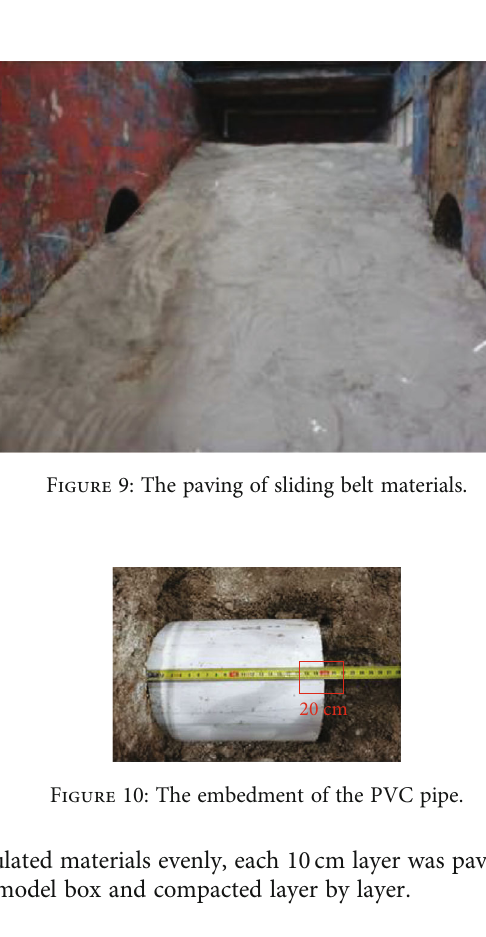
Figure 8: FBG monitoring elements [43].